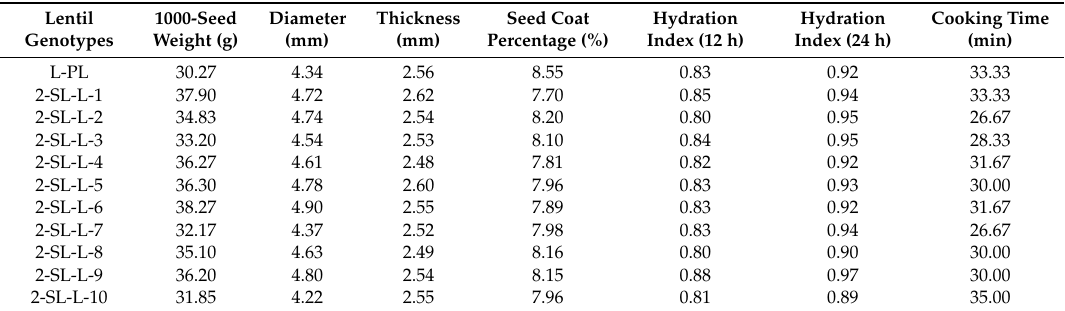
Table 4. Agronomical, morphological, seed coat %, hydration index, and cooking time of the parental landrace “Lefkada” and second-generation sister lines originating from “Lefkada”. Lentil